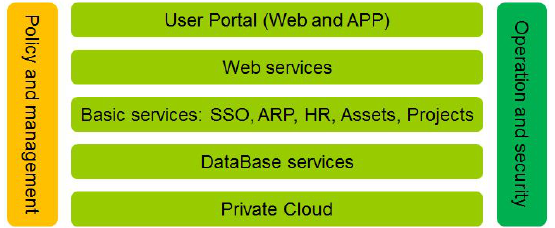
Figure 1. Architecture for IHEP web